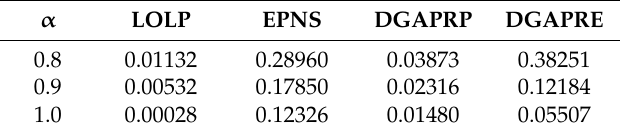
Table 3. Risk and DG active power reduction under different line transmission power limits.